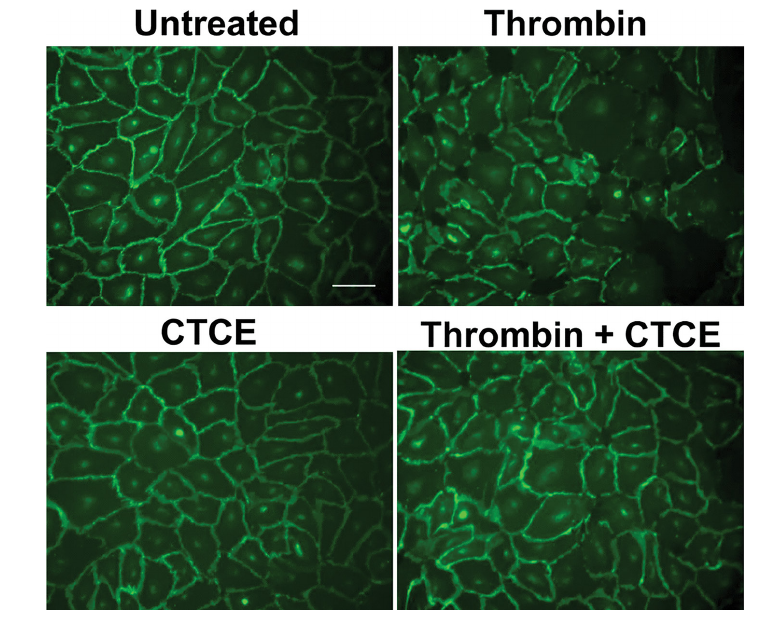
Figure 2. CTCE decreased thrombin-induced intercellular space in HMVECs. HMVECs were treated with thrombin (0.01 U), CTCE (10 μg/mL) or a combination of thrombin with CTCE for 30 min. Typical images of immunostaining of VE-cadherin (green) staining. Scale bar is 20 μ m. The results presented are representative of three experiments.